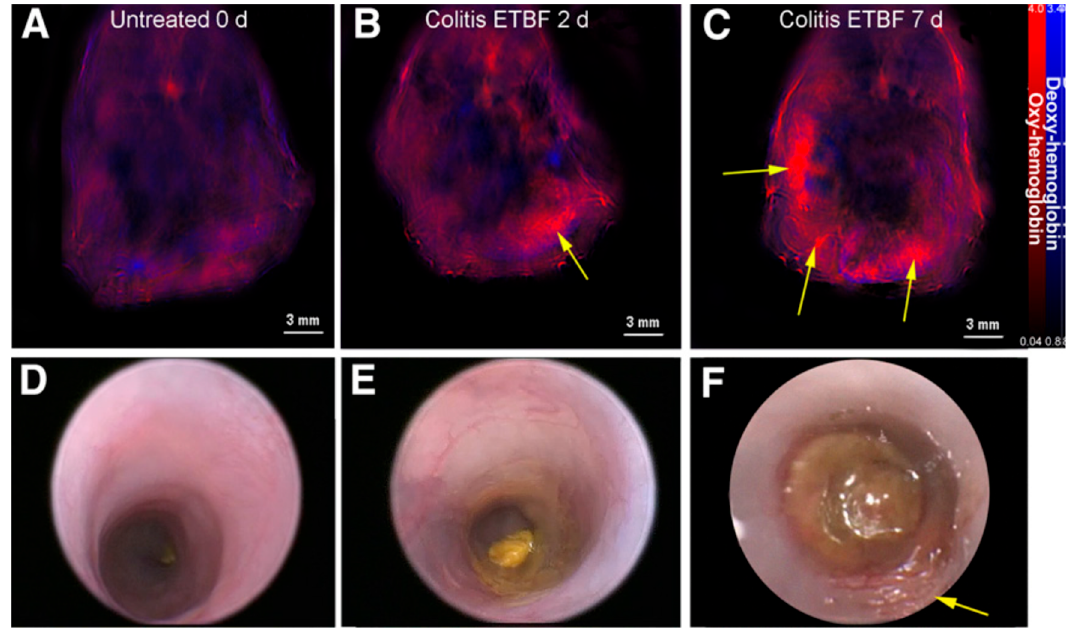
Figure 4. Multispectral optoacoustic tomography (MSOT) ( A – C ) and colonoscopic ( D – F ) images of murine colitis progression. Images were taken at t = 0, 2, and 7 days after bacterial inoculation. Yellow arrows indicate areas of inflammation correlating with colitis [67].